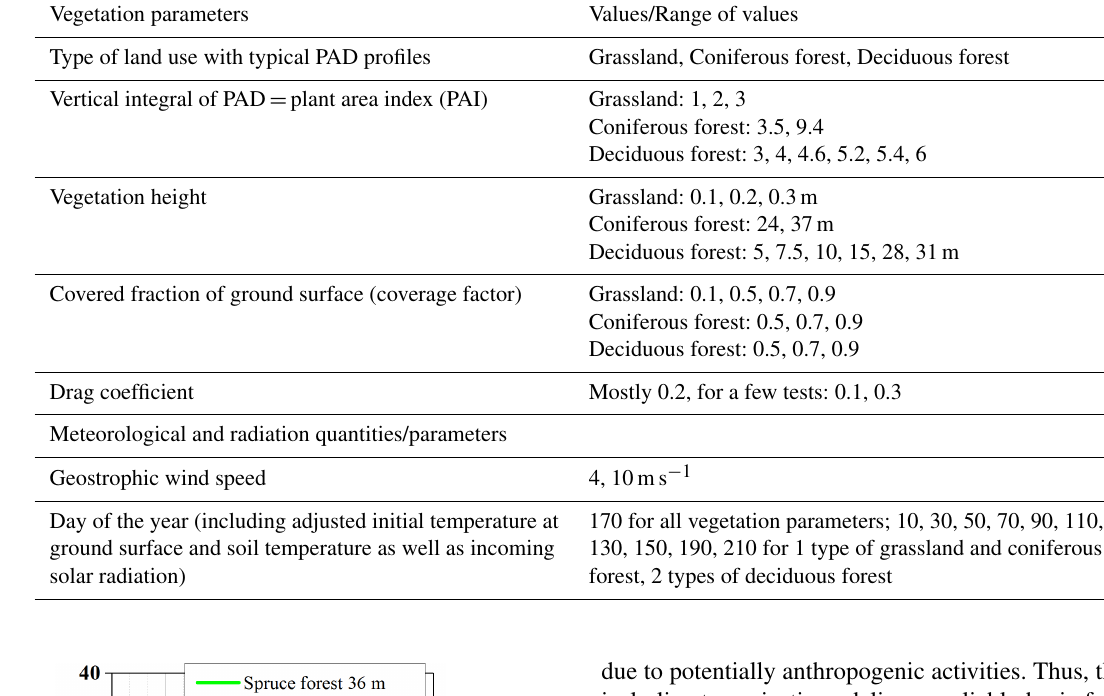
Table 1. Summary of important model parameters for HIRVAC2D sensitivity study. Vegetation parameters